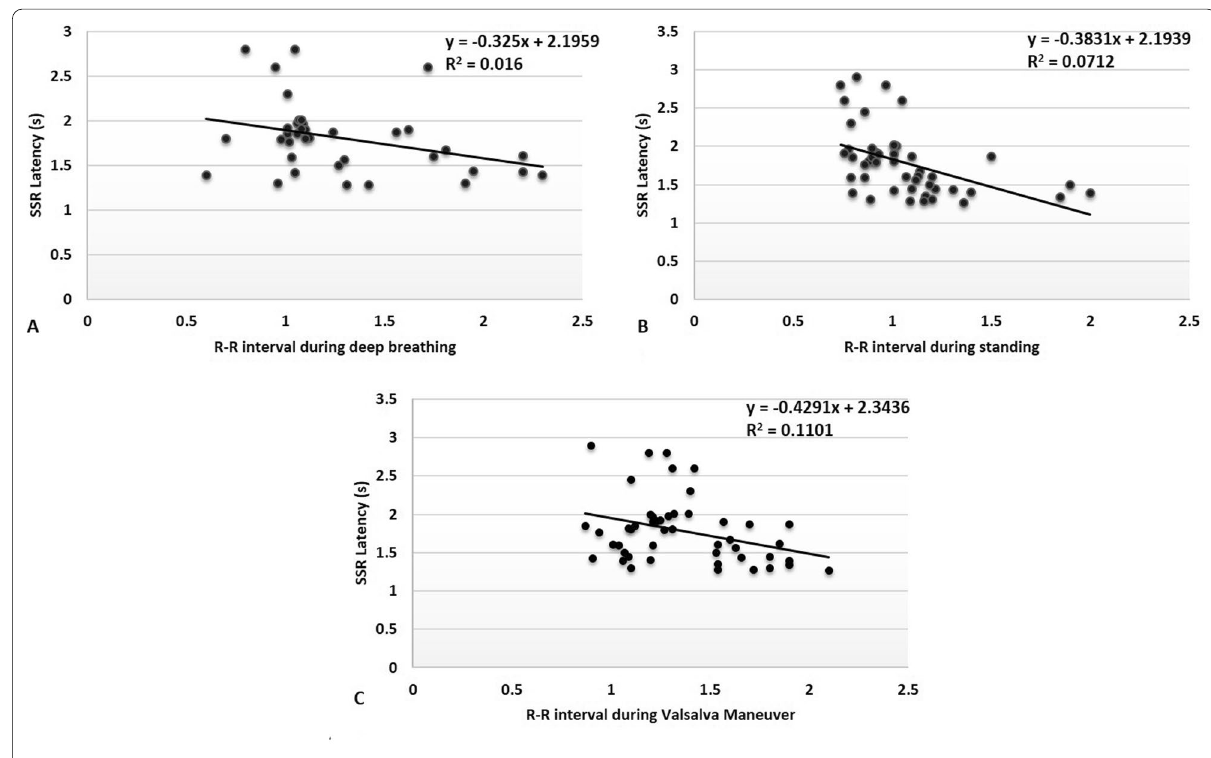
Fig. 1 Regression line of SSR latency and R–R interval during deep breathing ( A ), and R–R interval during rest ( B ), and R–R interval during Valsalva maneuver in patients with epilepsy ( C